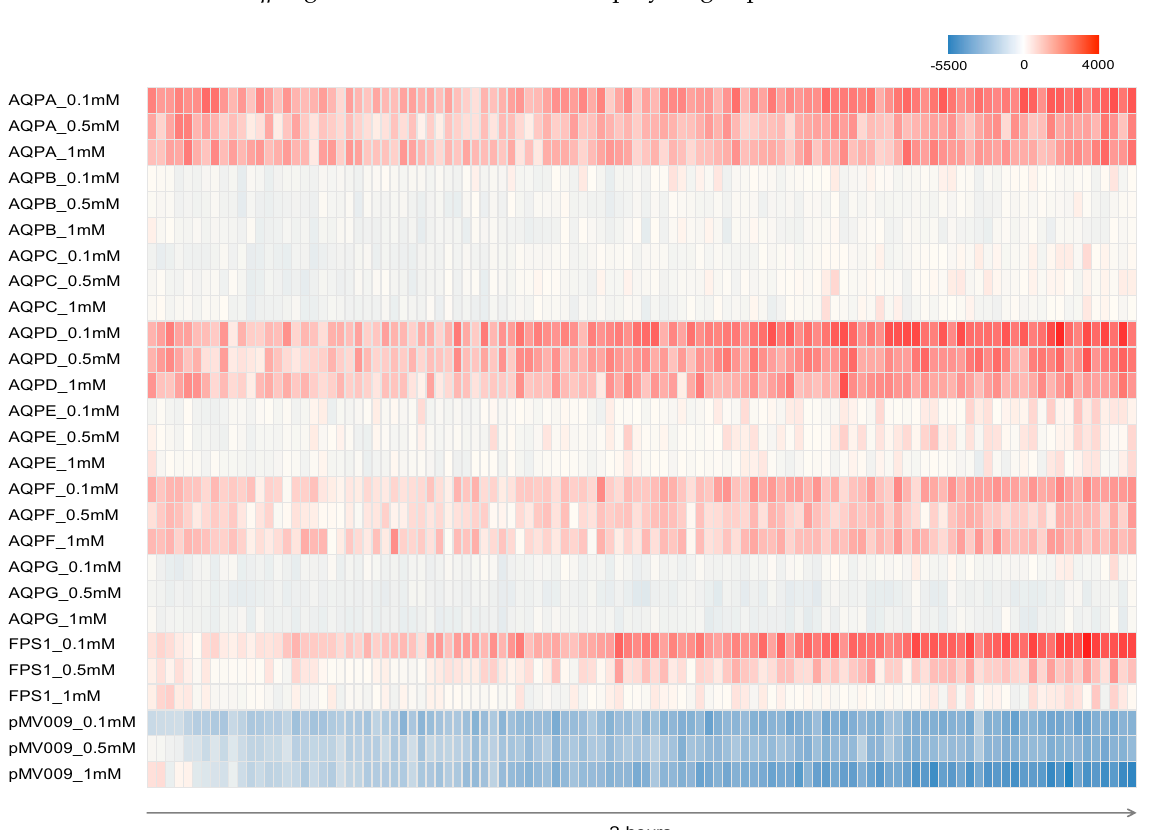
Figure 3. Hydrogen peroxide-dependent relative fluorescence in cultures of yeast expressing A. niger AQPs. Measurements of AQP-mediated hydrogen peroxide transport across membranes using the reactive fluorescent dye DCFHDA. Fluorescent intensity was measured for 2 h.